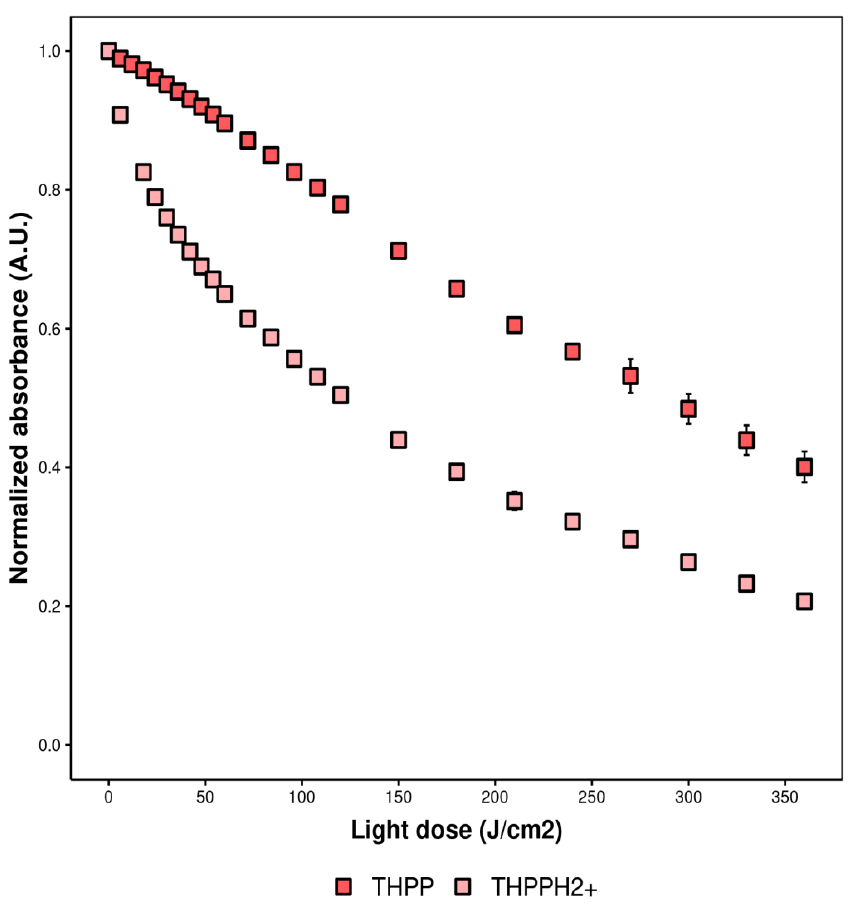
Figure 5. Compared photodegradation of THPP and THPPH 22+ , as both co-exist inside acetylated lignin nanoparticles, with the cationic species degrading faster upon blue-LED light irradiation. 2.5. Effect of the Aqueous Media on Porphyrins and Porphyrin Loaded Nanoparticles Through all the present work, the pH of the medium has played an important role at the different photophysical parameters of our nanoparticles. To corroborate and elaborate this aspect, the influence of the pH on the medium for the free porphyrins and the encap- sulated porphyrins was analyzed. In the literature, there are some examples where drug- loaded lignin nanoparticles are able to release their cargo into the media, in acidic pH [41– 44]. However, porphyrins loaded into acetylated lignin nanoparticles seem to be unaltered when the pH of the media fluctuates [20], and this could be due to a diminishing of the accessibility of the solvent during acetylated lignin nanoparticles formation [40], which could eventually lead to the permanent entrapment of porphyrins inside nanoparticles. 2.5.1. Effect of Fluctuations of pH into the Medium It has been hypothesized that, inside the nanoparticles, an acidic media permits the formation of THPPH 22+ , the protonated derivative of THPP, which appears to have an im- portant role on the fluorescence, singlet oxygen formation and photobleaching. To demonstrate if these observations are extensive to other porphyrins encapsulated inside nanoparticles, the influence of pH in the media for both free and encapsulated porphyrins was analyzed (Figure 6).